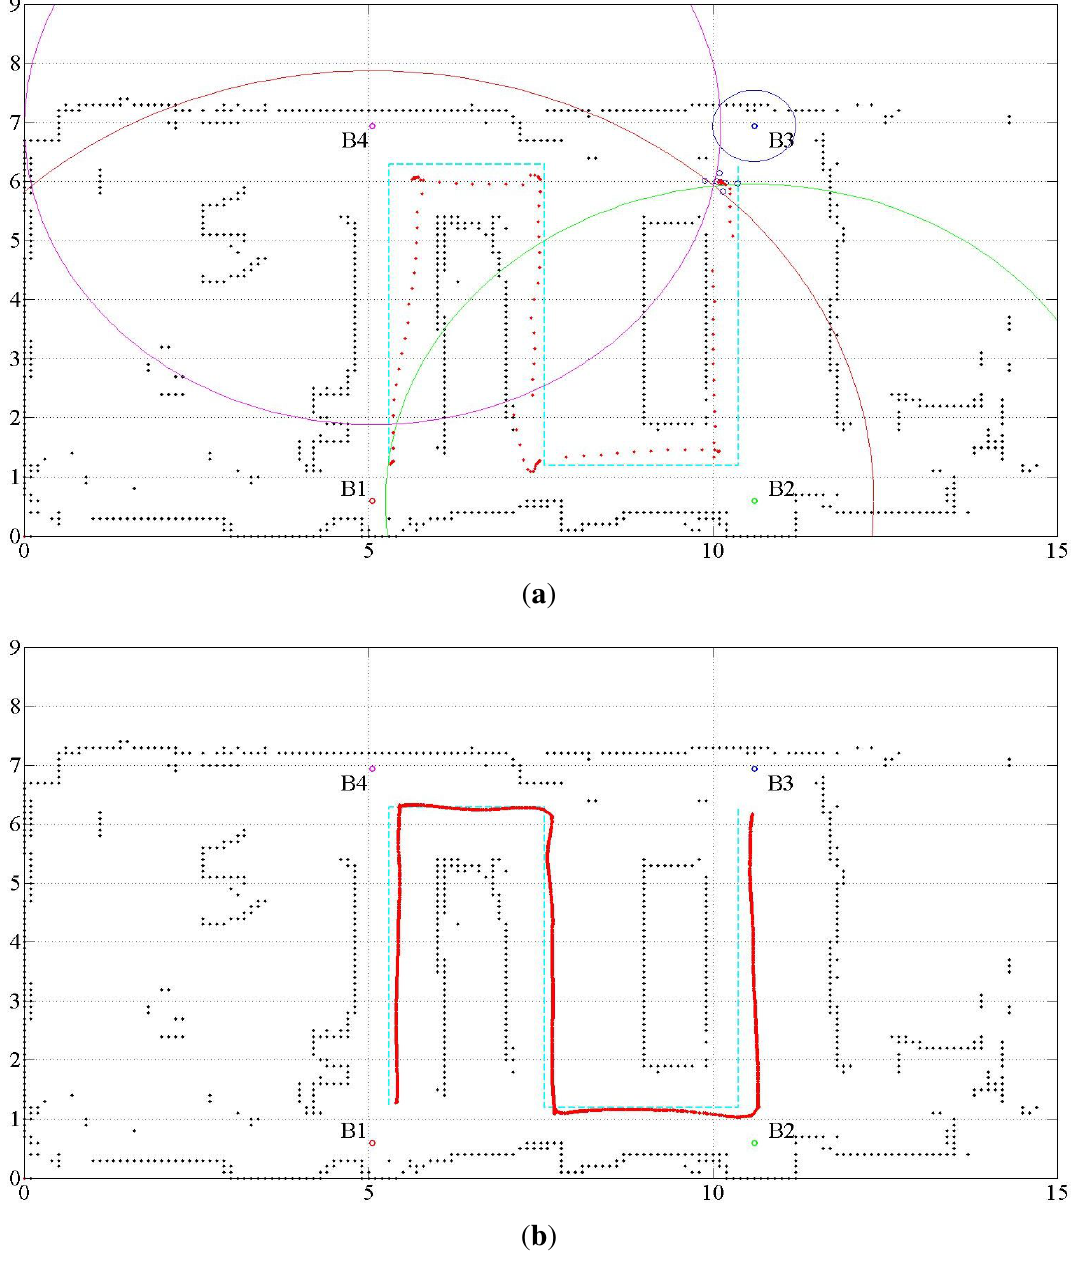
Figure 5. Estimated robot trajectory for the cases with no sensor fusion. ( a ) Estimated trajectory for the case of USAT only (Case 4); ( b ) estimated trajectory for the case of LRF only (Case